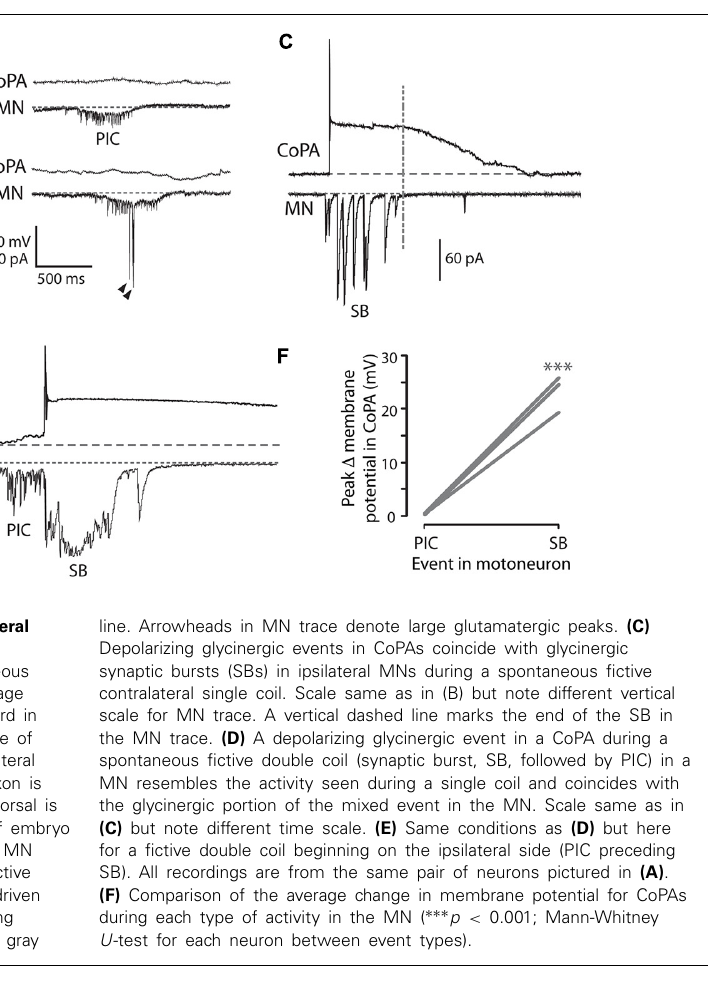
FIGURE 4 | Embryonic CoPAs are inactive during fictive ipsilateral coils and are depolarized by glycinergic inputs during fictive contralateral coils. (A) Image of filled neurons from a simultaneous whole-cell recording of a CoPA and ipsilateral MN. The upper image shows the filled cell bodies in fluorescence against the spinal cord in brightfield. The lower image shows the inverted fluorescent image of rhodamine-filled ipsilateral cell bodies with the ascending contralateral CoPA axon in focus spanning several somites (the ventral MN axon is obscured by the recording electrode). Rostral is to the left and dorsal is to the top. (B) Simultaneous whole-cell recordings from a 26 hpf embryo of activity in a CoPA (current clamp, top trace in all pairs) and a MN (voltage-clamp, bottom trace in all pairs) during a spontaneous fictive ipsilateral single coil. The CoPA is inactive during a gap junction-driven current (periodic inward current, PIC) in the ipsilateral MN. Holding potential of MN was –65 mV and baseline is shown as a dotted gray